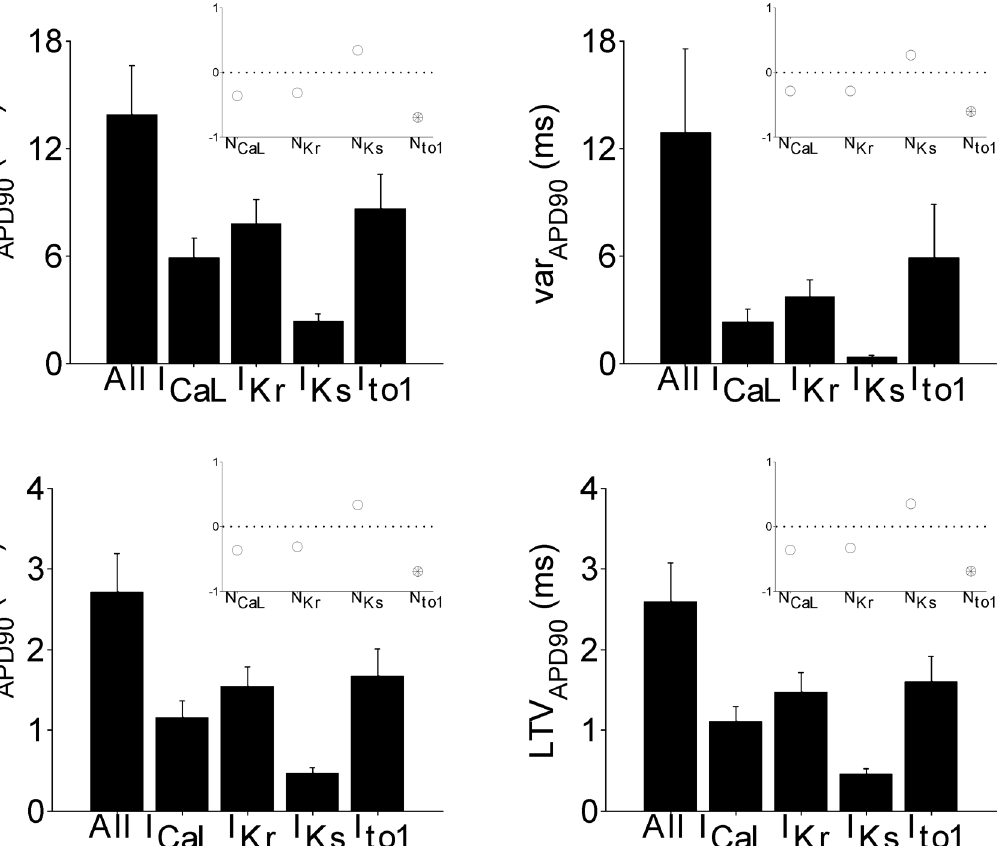
Fig 6. Variability in APD across the population of models under control conditions. Bar graphs showing the mean and standard deviation of APD variability measurements across the seventeen models from simulations where all currents are stochastic and also when stochasticity is incorporated into each individual current, under control conditions. The measures of variability are ran APD (top left), var APD (top right), STV APD (bottom left) and LTV APD (bottom right). Insets: Partial correlation coefficients between variability measures and ion channel numbers, with black dots and open circles indicating significant and not significant correlation,